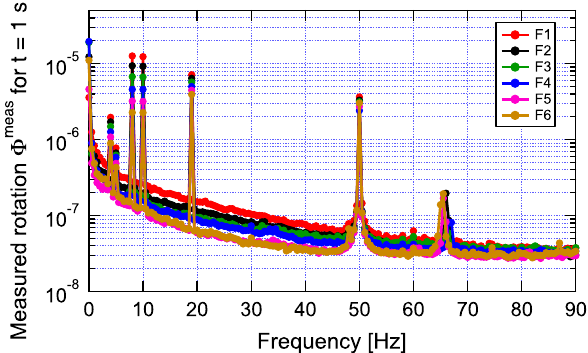
Fig. 15 Rotation spectra for the six finesse values rescaled to a 1 s integration time. The raw spectra have been rebinned by taking rms averages of the raw spectra in 0.5 Hz frequency intervals